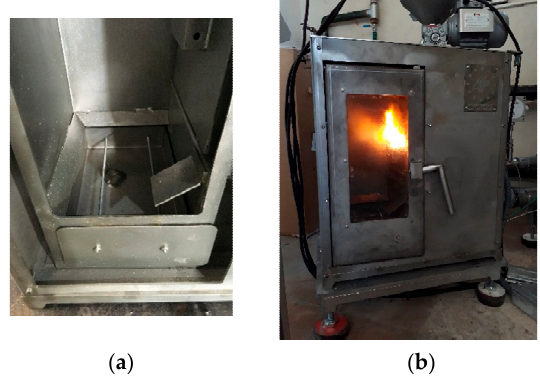
Figure 6. Incineration plant: box for ash collection ( a ) and door with glass window ( b ).